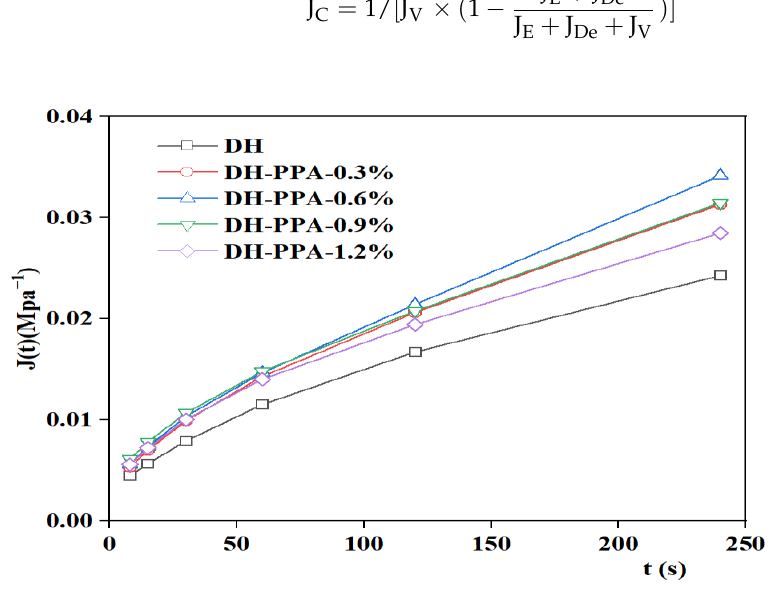
Figure 11. Creep flexibility curve at −12 °C.